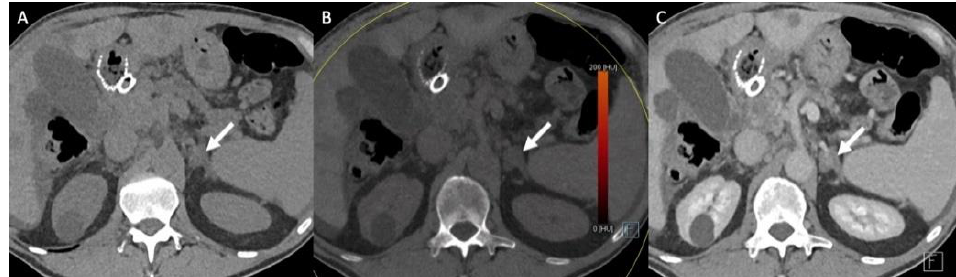
Figure 5. A 70-year-old man with a left adrenal lipid-poor adenoma known for 12 years without any changes in the imaging patterns (arrows). ( A ) The true unenhanced dual – CT image in the axial plane shows the left adrenal nodule (arrow) with a mean attenuation value of 13 HU. ( B ) In the virtual unenhanced (i.e., virtual non-contrast) dual-energy CT image in the axial plane, the adenoma (arrow) has a mean attenuation value of 14 HU, which is similar to the mean attenuation value obtained with the true unenhanced CT image. ( C ) In the venous phase CT image, the adrenal adenoma (arrow) has a mean attenuation value of 59 HU.